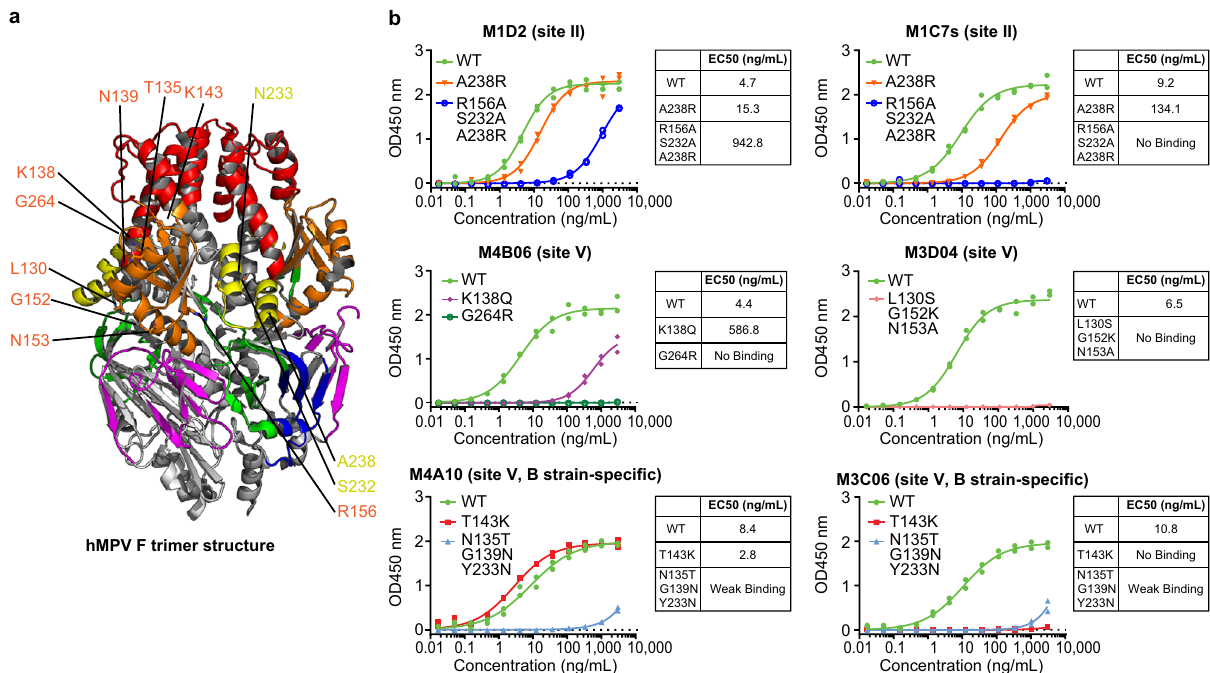
Fig. 3 Epitope mapping of selected site II and V hMPV F-speci fi c mAbs by binding to mutant F proteins. a Contact residues for different site II (yellow) and V (orange) mAbs were mapped on an hMPV PreF trimer structure (PDB: 5WB0, subtype A) 28 . b Binding of selected site II and V mAbs to unprocessed hMPV PreF and mutants, determined by ELISA with Expi293 cell culture supernatants containing expressed antigens. Dots indicate two replicates. Source data are provided as a Source Data fi le.